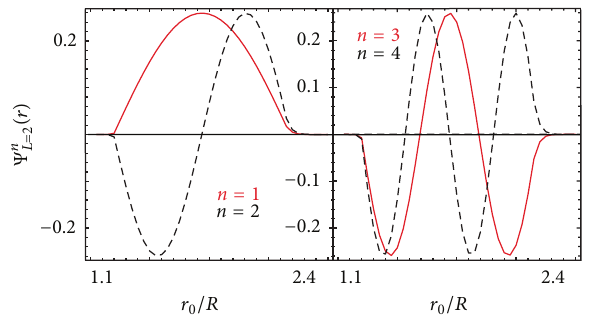
Figure 3: The wave functions for the ground state ( 𝑛 = 1 ) and first three excited states ( 𝑛 = 2, 3,4 ) are plotted for the effective potential 𝑉 between a charged particle and a spherical shell when 𝐿 = 2 . We eff chose 𝜖 1 = 2.4 , 𝜖 1 = 1 , and 𝑅 = 1